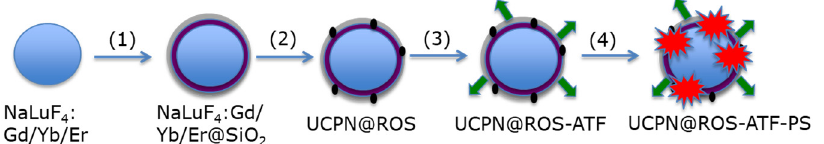
Figure 4. HeLa cell viability when treated with different concentrations of UCNPs-RB with and without irradiation (808 nm, 0.67 W/cm 2 , 10 min). Adapted from Wang et al. [23]. Lu et al. [24] designed organosilica-shelled β -NaLuF 4 :Gd/Yb/Er (Lu/Gd/Yb/Er: 50/30/18/2 in mol%) UCNPsI with a rattle structure. NPs were adsorbed either with zinc